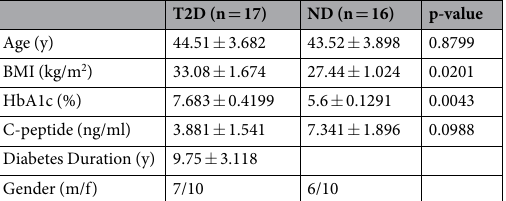
Table 1. Cohort characteristics of type 2 diabetic and non-diabetic patients analyzed in Fig.